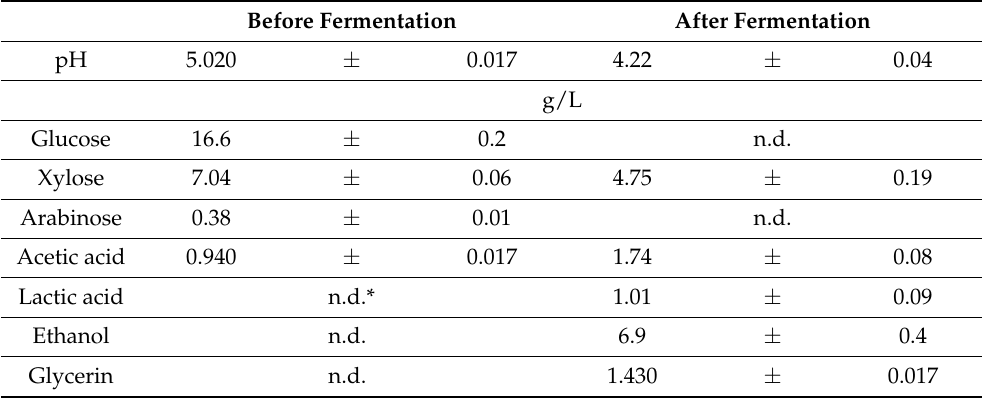
Table 2. Metabolite yields from yeast after fermentation of barley straw simulation hydrolysate. All values are given in g/L (except of pH-values) and represent the mean with corresponding standard deviation. Before Fermentation After Fermentation pH 5.020 ± 0.017 4.22